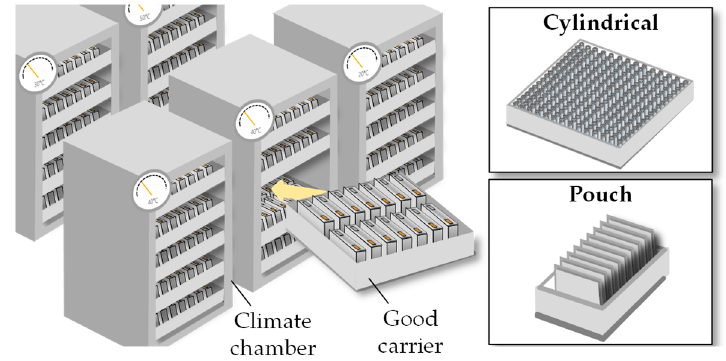
Figure 3. Schematic of the pre-treatment [9]